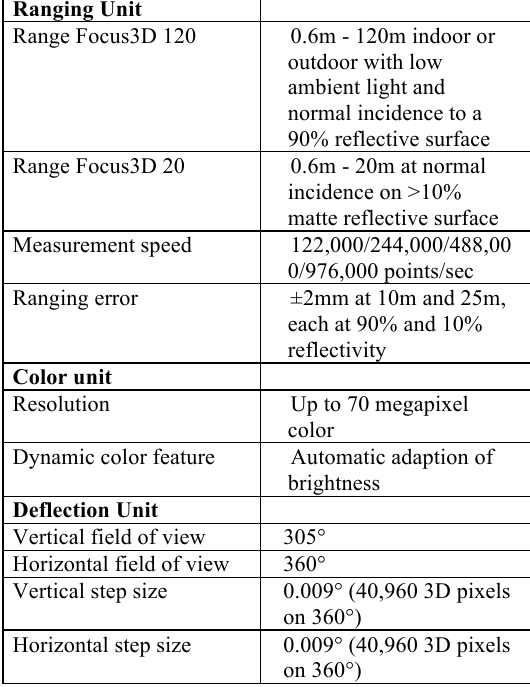
Table 3. Faro Focus 3D specifications